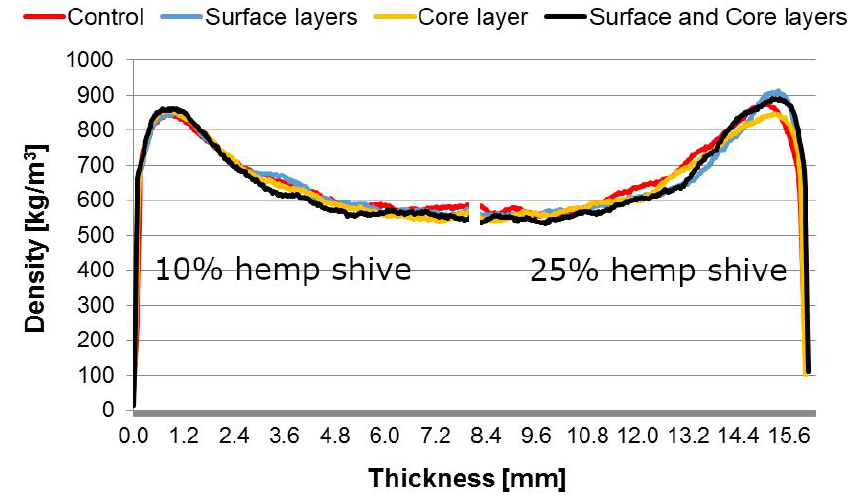
Figure 3. Density profile of manufactured particleboards.